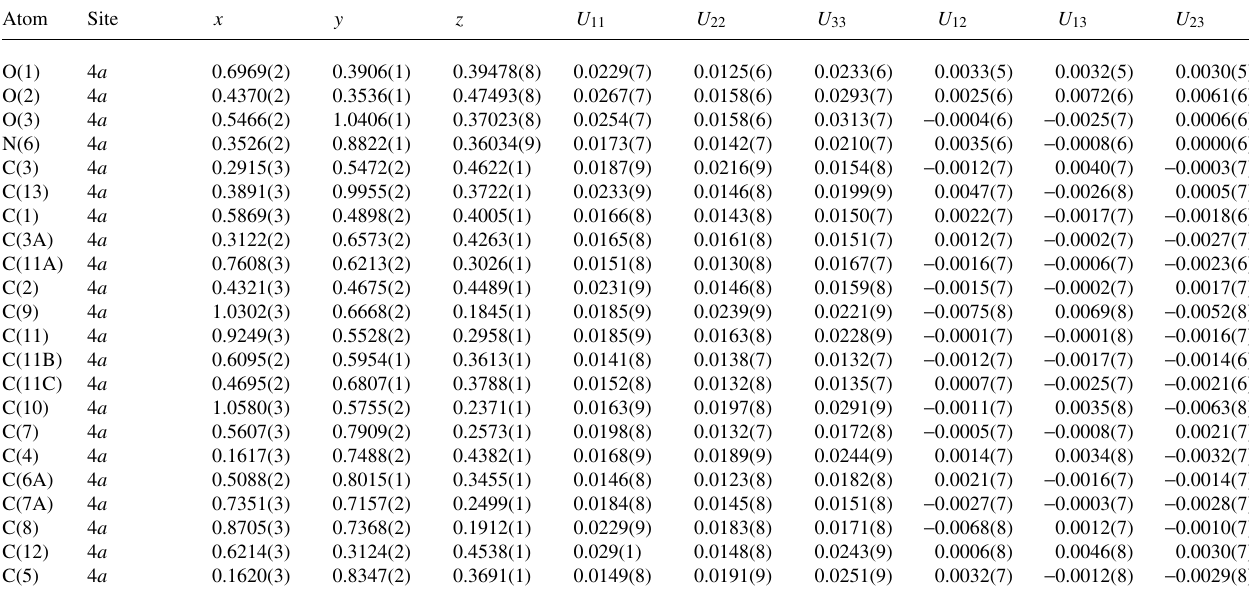
Table 3. Atomic coordinates and displacement parameters (in Å 2 )